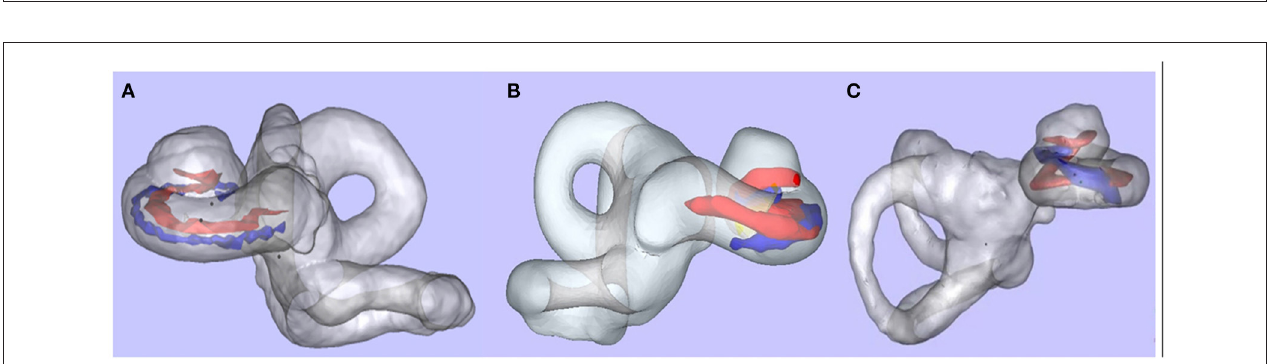
FIGURE 1 | Robot-assisted insertion with a lateral wall or perimodiolar electrode array. For the lateral wall EA (e.g., CS-10A TM), the crest of the EA (arrow in D ) was clamped by the robotic tool (A) , the EA was robotically advanced until the round window marker reached the round window, then the EA was released. For the perimodiolar EA, the crest was clamped by the robotic tool (arrow on the left in E ), the EA was robotically advanced until the first marker reached the round window (B) , then the stylet was held manually (arrow on the right in E ). The EA was then robotically advanced until the round window marker reached the round window (C) , then the stylet was manually retracted, and finally, the EA was robotically released (Robot-assisted AOS technique).